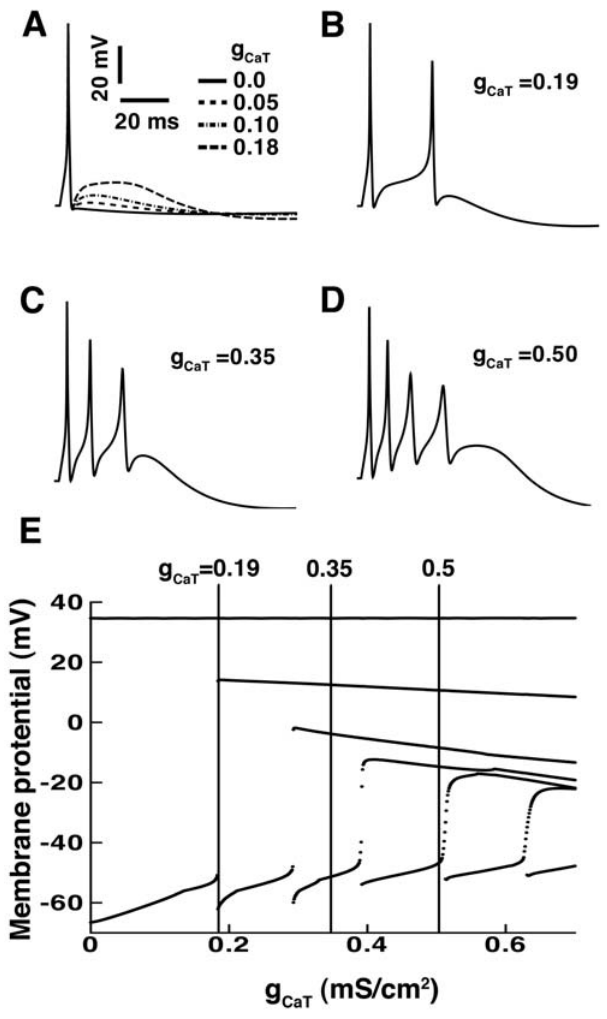
Figure 5. T-type Ca 2 + channels underlie somatic afterdepolar- izing potentials (ADP) and promote burst firing in the model neuron. Action potentials were elicited in response to a brief current of 0.2 nA for 5 ms. (A) Increasing g CaT increases after- depolarizing potential (ADP) in the model neuron. Shown are g CaT (mS/ cm 2 )=0.0 (solid line), 0.05 (dashed line), 0.10 (dash-dot line), and 0.18 (long dash line), respectively. (B) When g CaT= 0.19, a second spike is generated. Panels (C) and (D) correspond to the values of g CaT =0.35 and 0.5, respectively. (E) The effect of changing g CaT on burst generation in the model neuron is shown for a range of g CaT from 0.0 to 0.7 mS/cm 2 . Maximums in membrane potential (for each spike within a burst) generated at each value of g CaT are shown. Lines are drawn vertically through values in panels B (g CaT= 0.19, line intersects three points indicating three voltage maxima-two spikes and a wide spike prior to termination), C (g CaT= 0.35, line intersects four voltage maxima-three spikes and a wide spike prior to termination) and D (g CaT= 0.5, line intersects five points indicating five voltage maxima-four spikes and a wide spike prior to